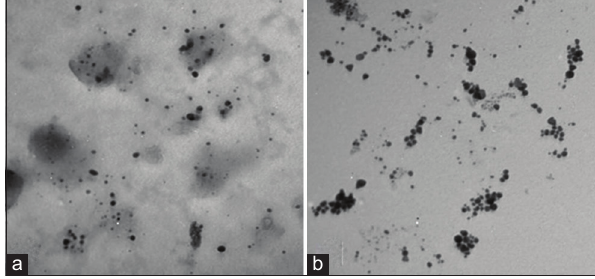
a Figure-2: (a) CNP with average size 25.1 nm. (b) SNP with average size 26.5 nm.